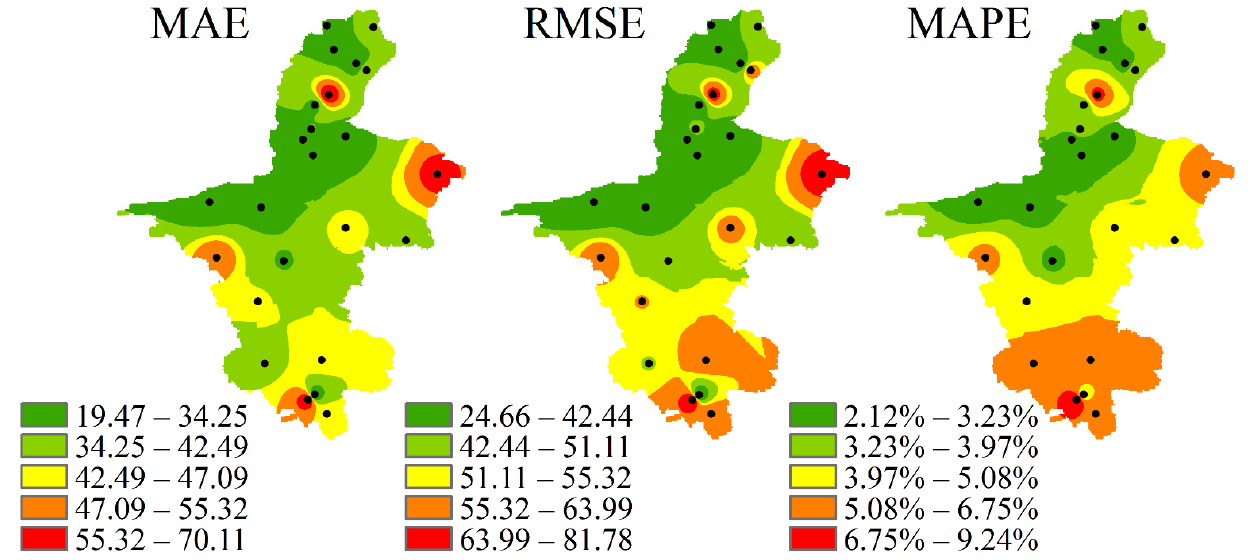
Figure 8. Analysis of extrapolated forecast error, mean absolute error (MAE), root mean square error (RMSE), and mean absolute percentage error (MAPE).